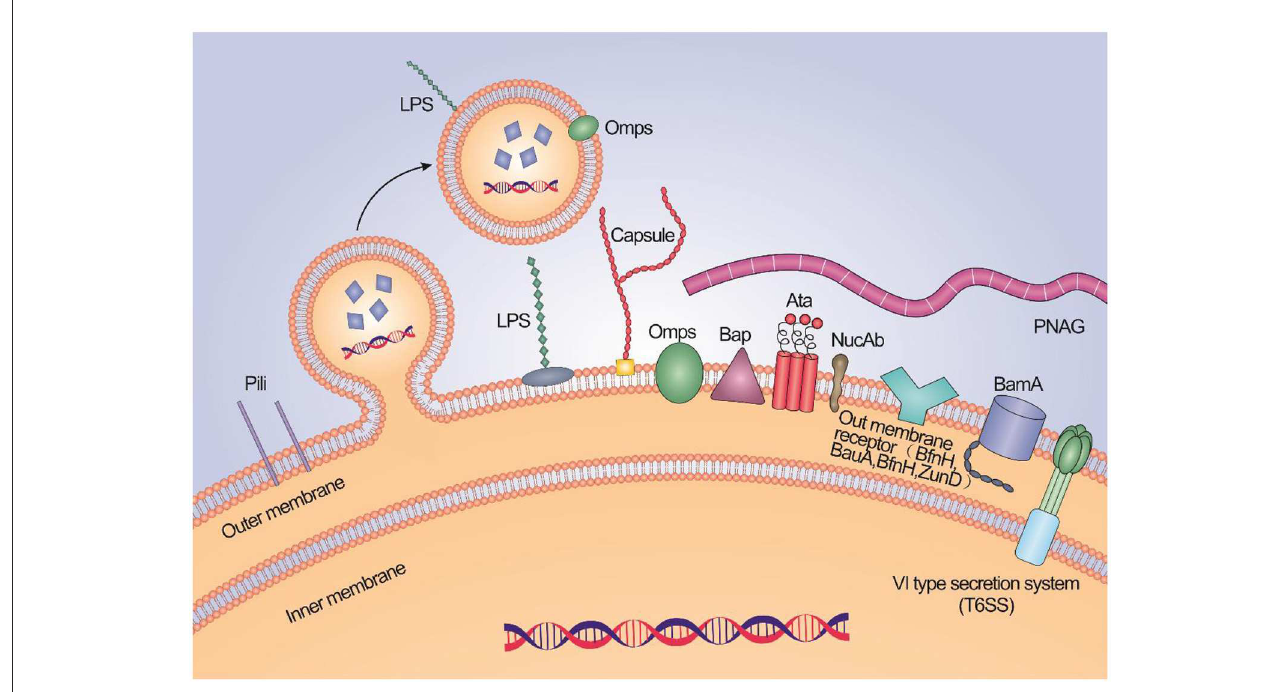
FIGURE1 A schematic illustration about the high potential vaccine targets and the typical structure of membrane of A. baumannii .